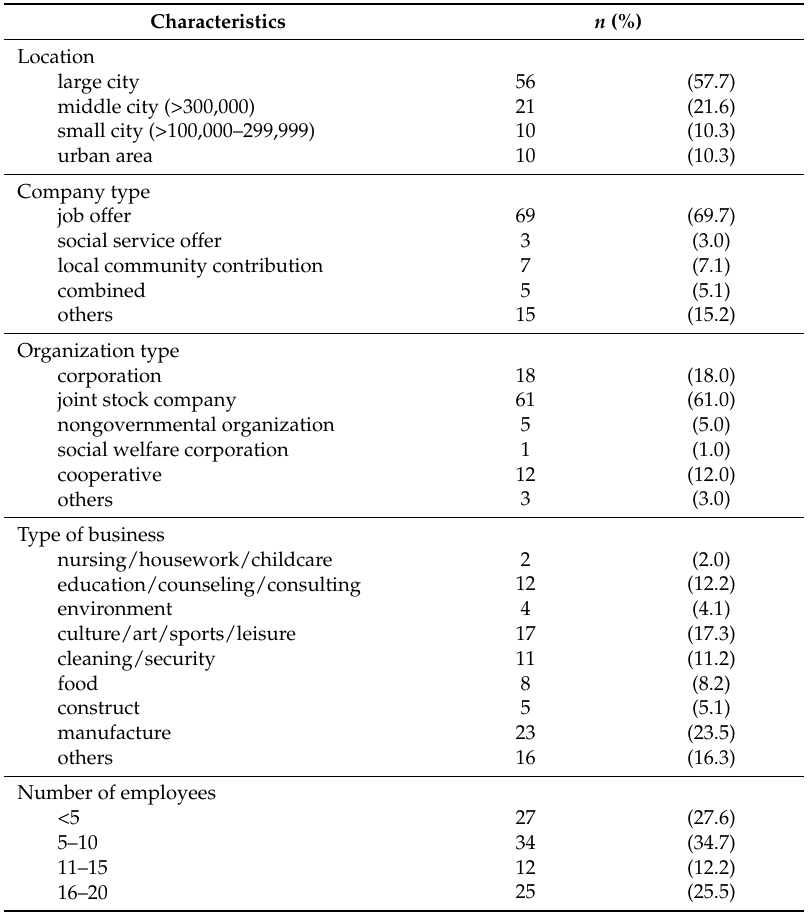
Table 1. Descriptive statistics of social enterprise sample ( n = 100).